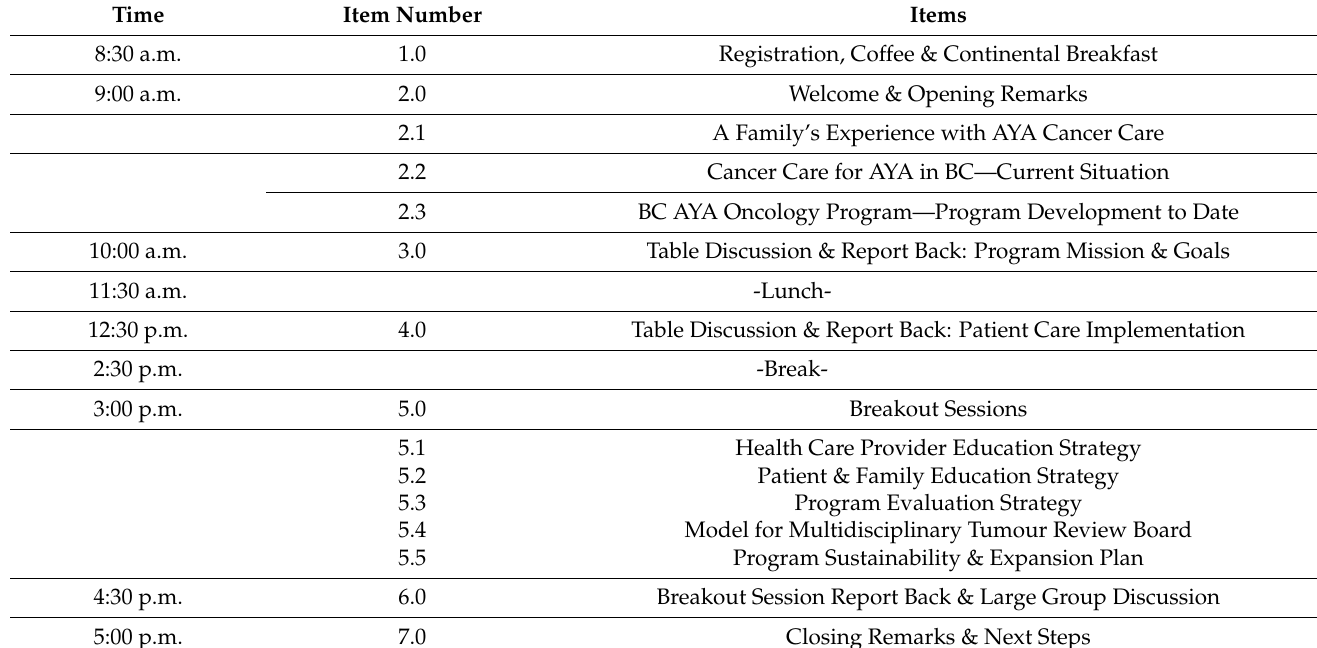
Table Discussion & Report Back: Patient Care